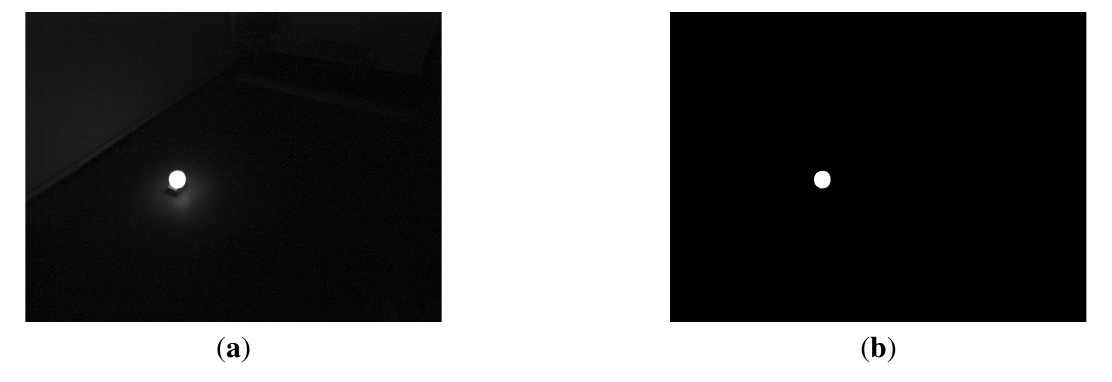
Figure 2. Images used for calibration. ( a ) Original captured image; ( b ) Binary image after simple